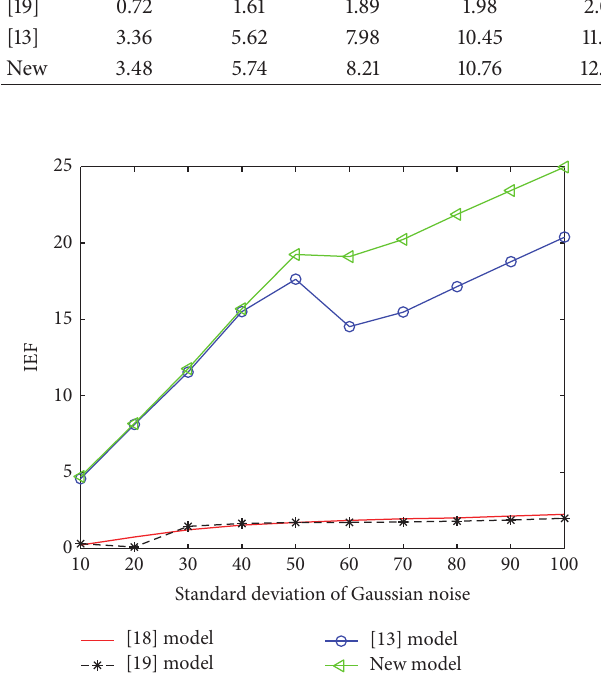
Figure 13: IEF graph of [13, 18, 19] and new algorithms for various Gaussian noise for Tennis video sequence.